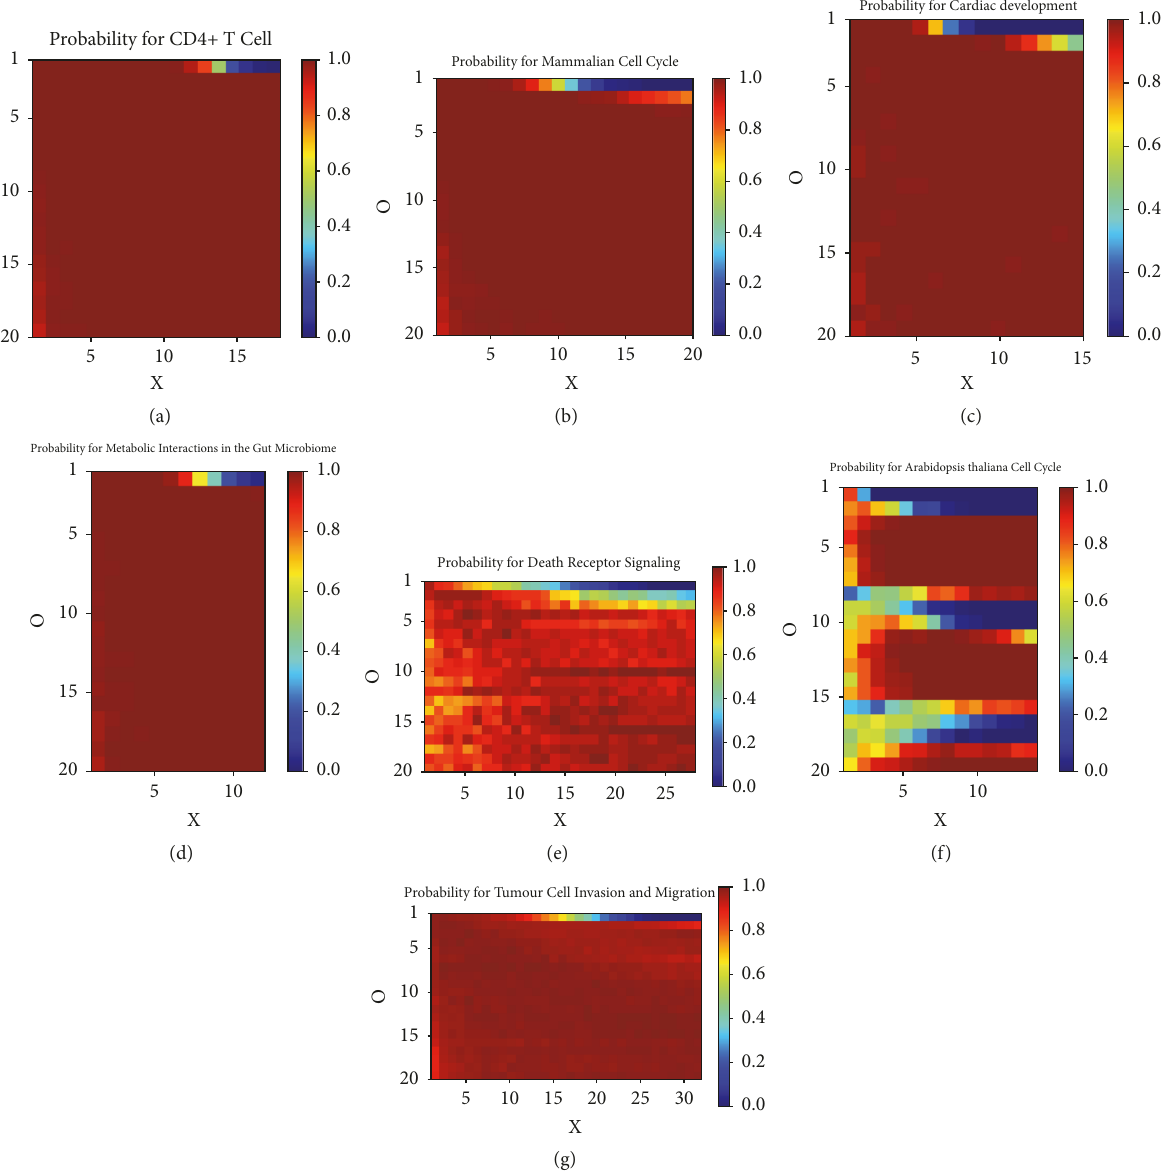
Figure 7: Probability of generating antifragile networks depending on 𝑋 and 𝑂 for different biological Boolean networks with 𝑇 = 200. 5000 different initial states were used for each network. (a) CD4+ T cell differentiation and plasticity . (b) Mammalian cell-cycle . (c) Cardiac development . (d) Metabolic interactions in the gut microbiome . (e) Death receptor signaling . (f) A. thaliana cell-cycle . (g) Tumor cell invasion and migration